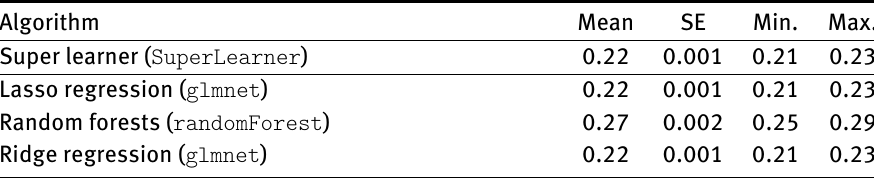
Table B1: Distribution of MSE for compliance